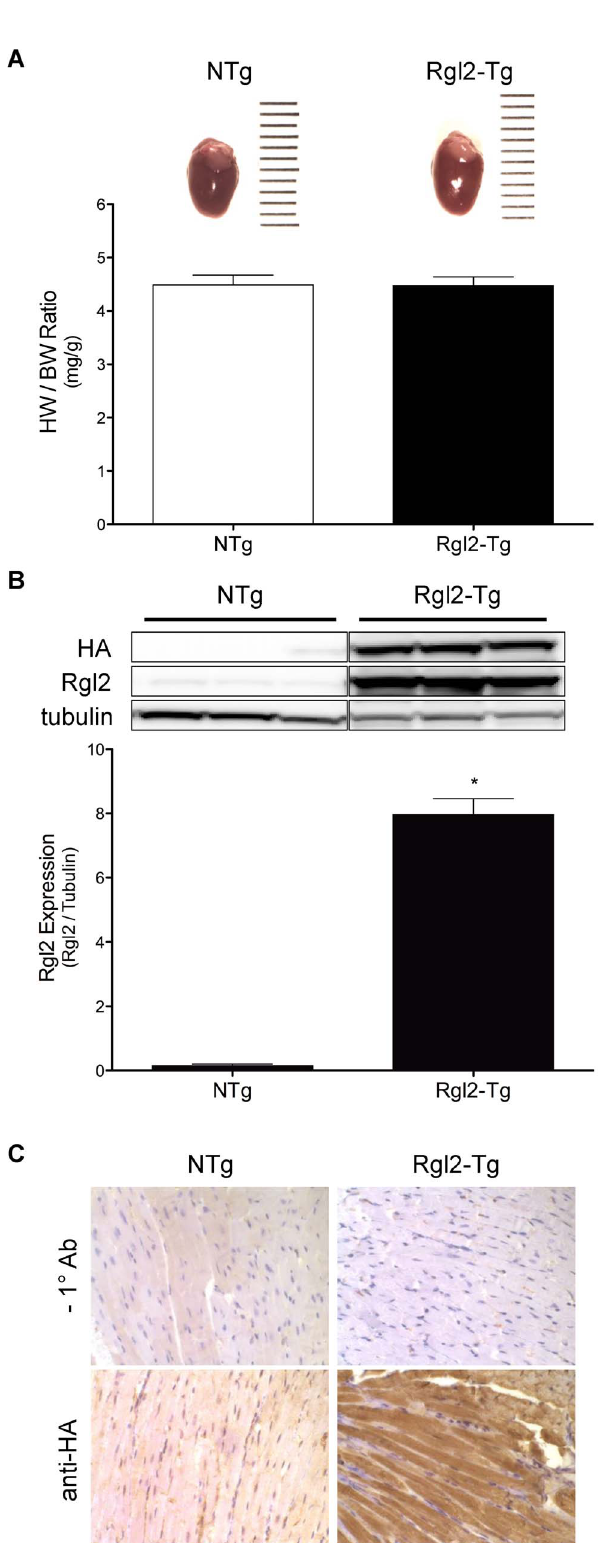
Figure 1. Transgenic expression of Rgl2 in mice. A ) Representa- tive pictures of hearts from nontransgenic (NTg) and transgenic mice with cardiac specific overexpression of Rgl2 (Rgl2-Tg). Ruler gradations are 1 mm. Graph represents the mean 6 SEM from at least 4 different aged-matched hearts. * denotes significant difference from NTg. B ) Tissue homogenates from hearts of NTg and Rgl2-Tg mice were probed